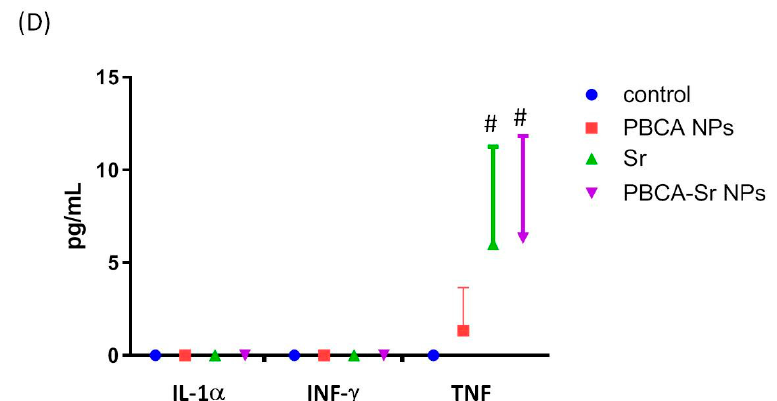
Figure 3. Cell viability (( A ). MTT assay), cell proliferation (( B ). WST-1 assay) and cytotoxicity (( C ). LDH assay) on committed MSCs treated with strontium ranelate (Sr), and inflammatory cytokines ( D ), PBCA NPs or PBCA-Sr NPs for 24 h. n = 6; * p < 0.001, # p < 0.05.